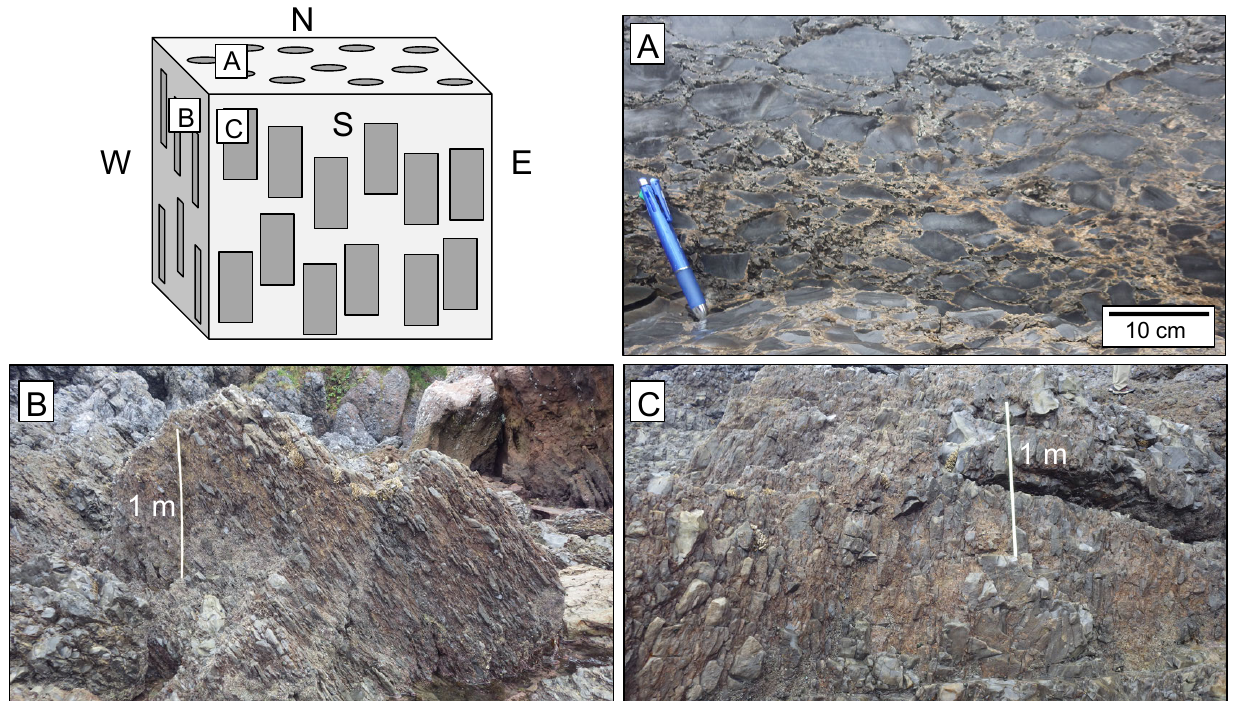
Figure 7: Schematic sections and photographs showing morphology of the obsidian clasts. Clasts are vertically elongated and flattened, exhibiting a platy shape. Matrix shows a red color.